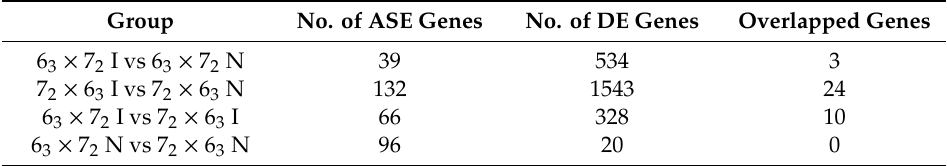
Table 7. ASE and DE genes of four comparison groups.